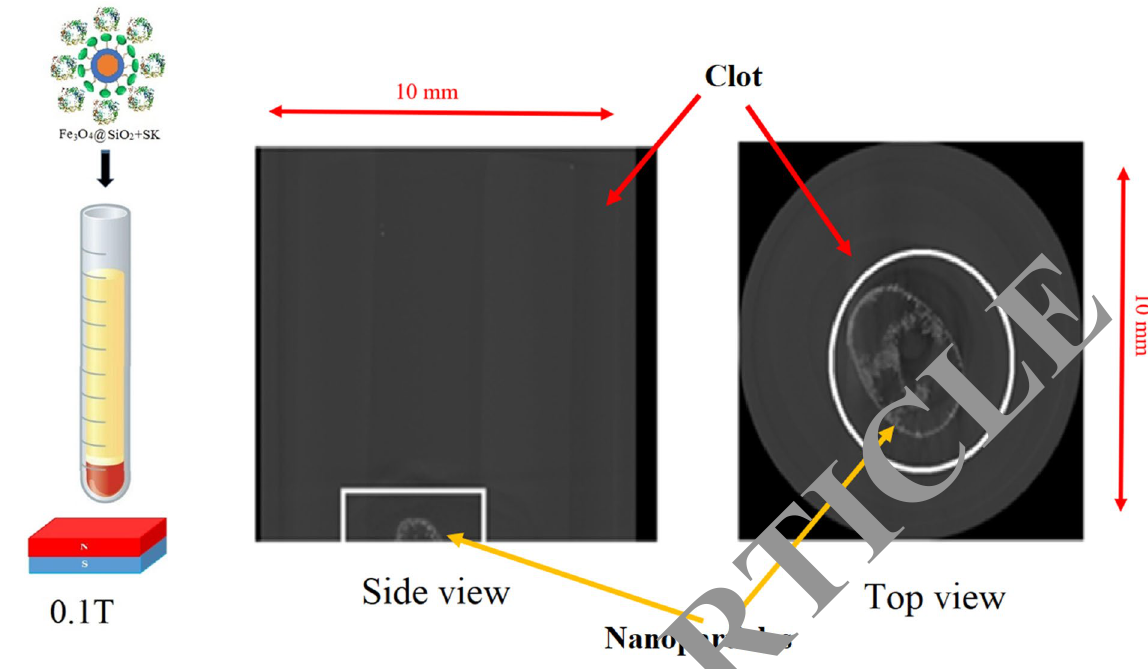
Figure 9. Micro CT-scan image clot under magnetic field 0.1 T. Schematic of applying magnetic field on clot and magnetic nanoparticles, side view and top view.